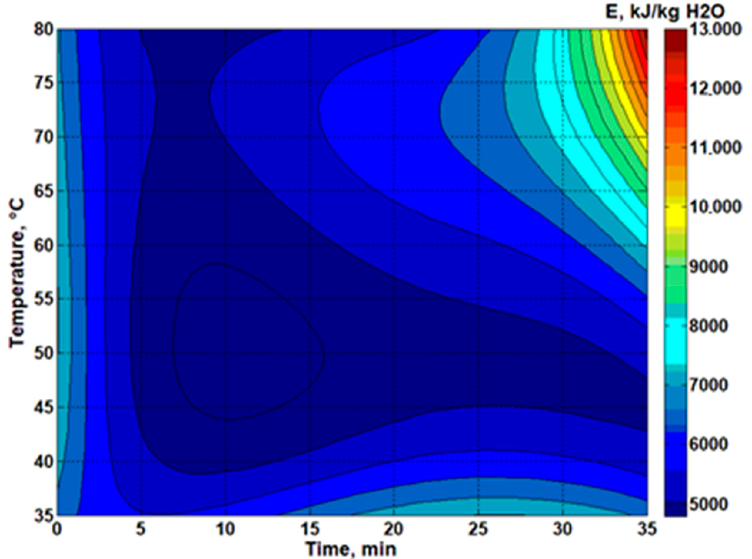
Figure 15. Drying kinetics in the torbed installation for Australian lignite.